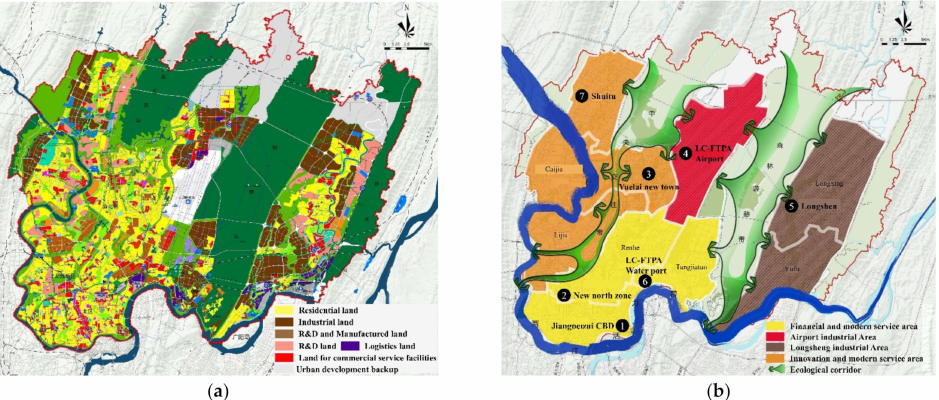
Figure 3. ( a ) Layout planning of construction land in LNNA from 2010 to 2020; ( b ) functional area planning in LNNA from 2010 to 2020 (source: the author compiled from the comprehensive planning of the Liangjiang National New